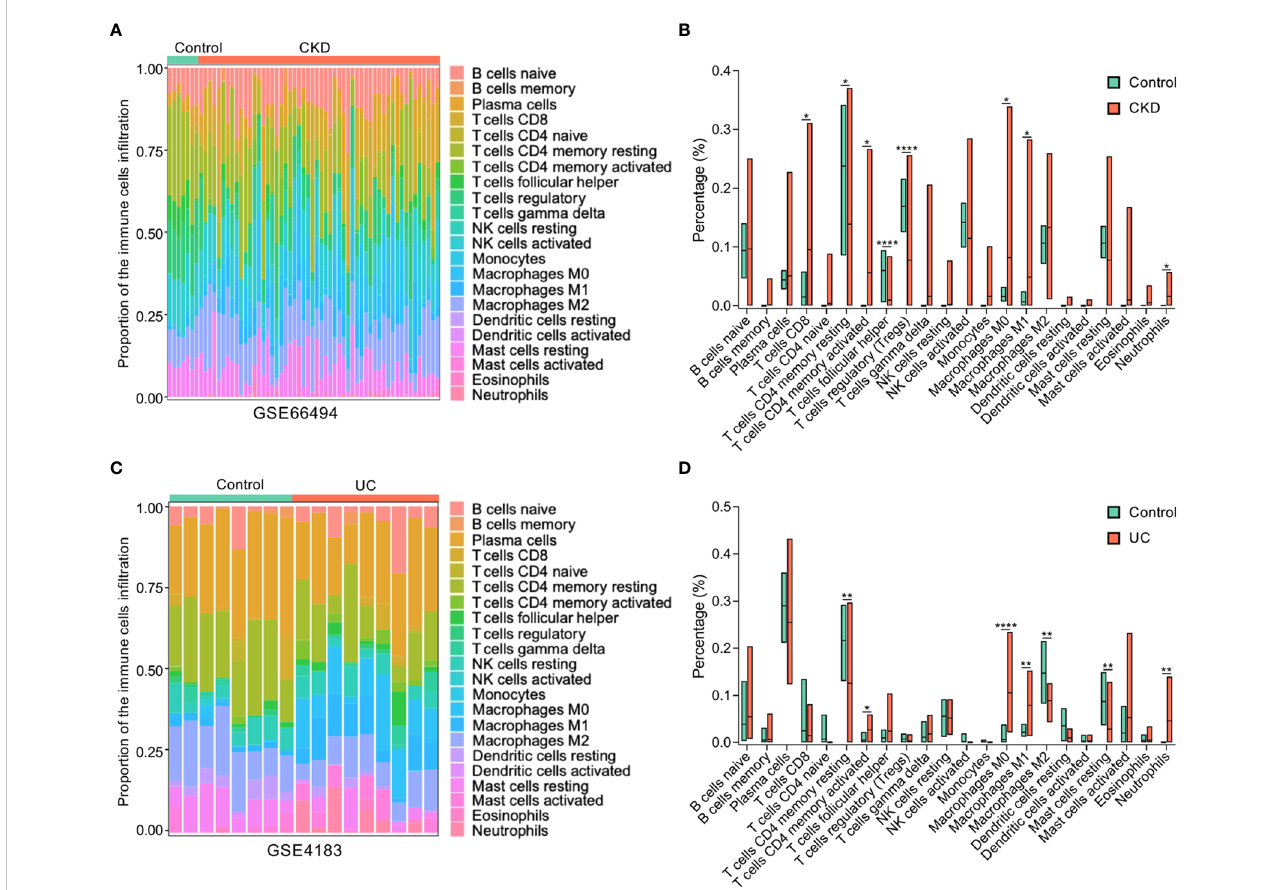
FIGURE 6 Composition of in fi ltrating immune cells in CKD and UC. (A) The proportion of immune cell populations in kidney was determined by CIBERSORT. (B) Comparison of renal immune in fi ltration between healthy control and CKD patients. (C) The proportion of immune cell populations in colon was determined by CIBERSORT. (D) Comparison of colonic in fi ltrating immune cells between healthy control and UC patients. Stacked bar plots show the relative composition of immune cell subsets in CKD (A) and UC (B) . CKD, chronic kidney disease; UC, ulcerative colitis; ****P < 0.0001; **P < 0.005; *P < 0.05; (unpaired